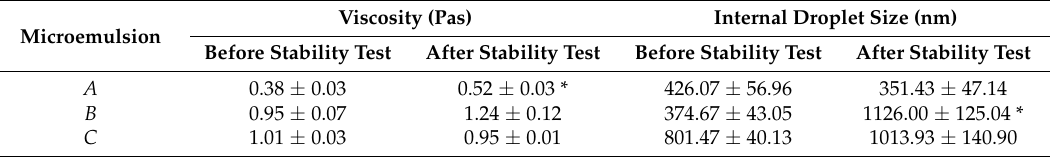
Table 2. Viscosity and internal droplet size of microemulsions before and after the heating-cooling stability test.